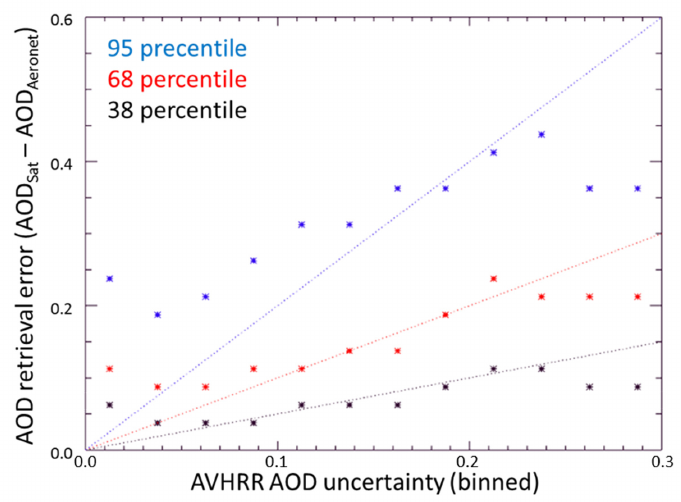
Figure 8. Assessment of the information content of uncertainties in the L2B product for 2008: 3 percentile values (for 38%, 68%, and 95% in black, red, and blue) of the retrieval error as function of the predicted uncertainty; expected functionality is depicted with the dashed lines of gradient 0.5, 1.0, and 2.0.